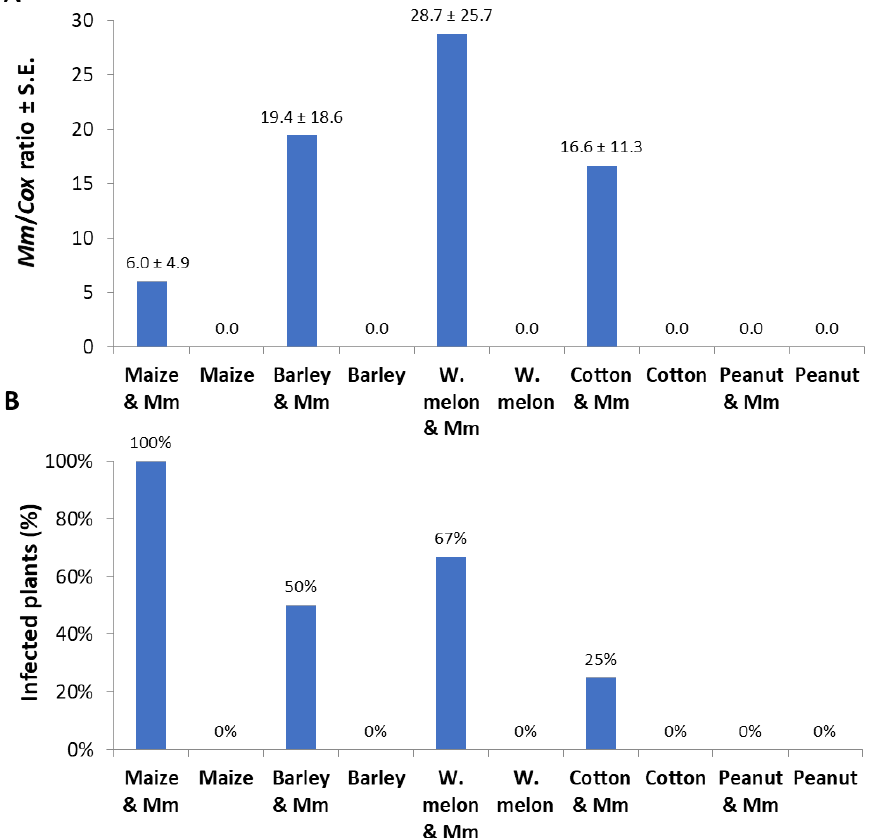
Figure 5. Detached roots pathogenicity assay quantitative real-time PCR results: The experiment is described in Figure 4. The qPCR method used is very sensitive, and some of the measurements (repeats) resulted in zero values because of an objective difficulty in achieving high and uniform inoculation with this particular pathogen Israeli strains. Therefore, two measures to describe the results were used: pathogen colonization degree (mean relative value) and incidence (percentages of infected plants that had positive detection using the qPCR method). ( A ) Pathogen colonization degree: M. maydis relative DNA ( Mm ) levels normalized to the housekeeping gene cytochrome c oxidase ( Cox ) DNA. ( B ) Incidence: rate of infected plants (with M. maydis DNA inside their tissues) in percentage, identified by the qPCR. Controls—noninfected plants tested in these experiments (all had zero levels of M. maydis relative DNA). Values represent the average of five replications ± standard error.